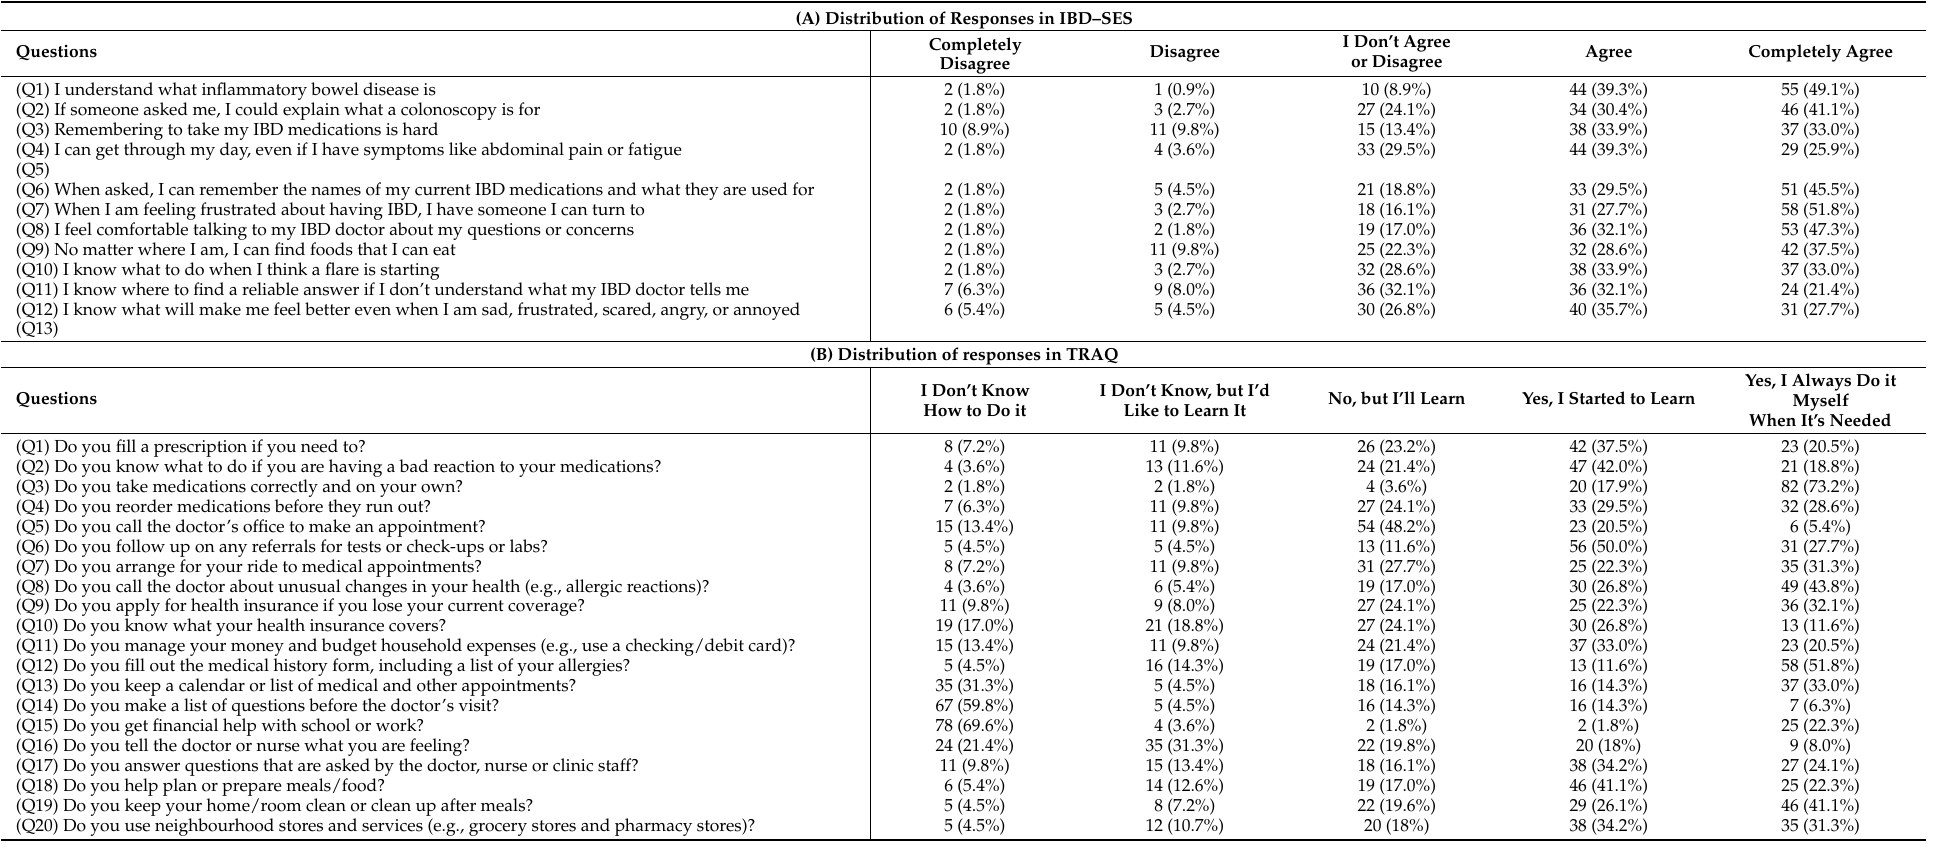
Table 2. Distribution of responses in IBD–SES ( A ); TRAQ ( B ); STARx (STARx-A: C , STARx-P: D